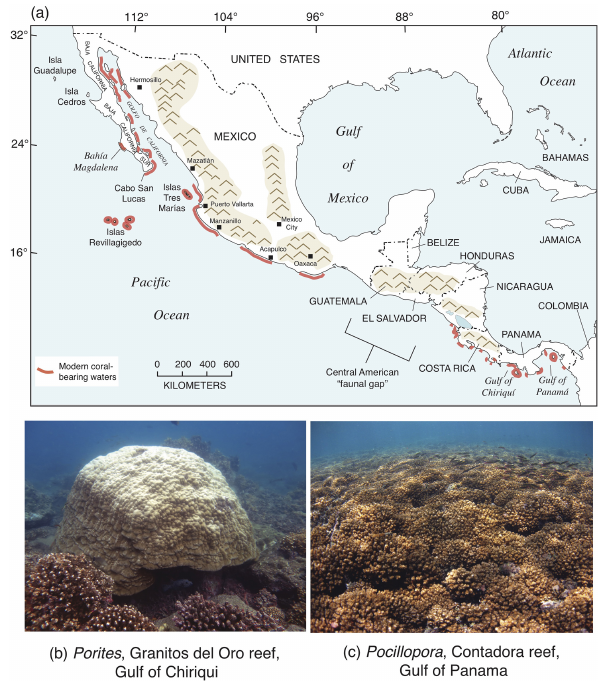
Figure 7. (a) Map showing the distribution of living hermatypic corals and coral reefs along the Golfo de California coasts of Mex- ico, the Pacific coast of Mexico, and the Pacific coast of Central America (compiled from Reyes-Bonilla and López-Pérez, 2009; Al- varado et al., 2010; Glynn et al., 2017). (b, c) Examples of modern hermatypic corals along the Pacific coast of Central America (pho- tographs courtesy of Lauren Toth, U.S. Geological Survey).